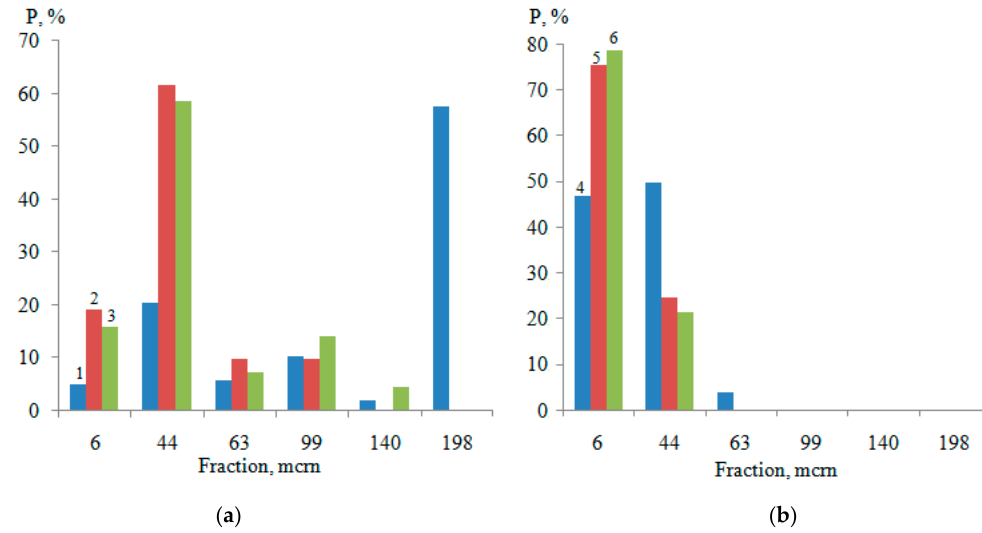
Figure 8. Distributions of titanium dioxide dispersions by size classes in water ( a ) and in a 30% film-forming agent solution ( b ) with CS = 0.25g/dm 3 (1—H 2 O, 2—H 2 O + 0.25g/dm 3 (PC), 3—H 2 O + 0.25g/dm 3 (NaPA), 4—30%, 5—30% + 0.25g/dm 3 (PC), 6—30% + 0.25g/dm 3 (NaPA)). Changes in the minimum average diameter of particles in suspensions with different film-forming agent content are presented in Figure 9.